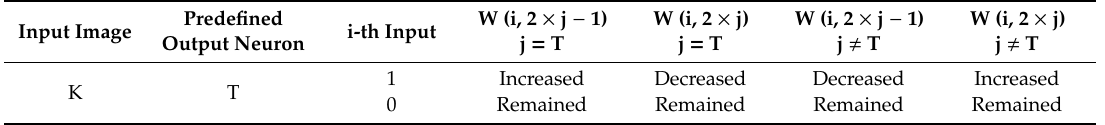
Table 3. Guide training